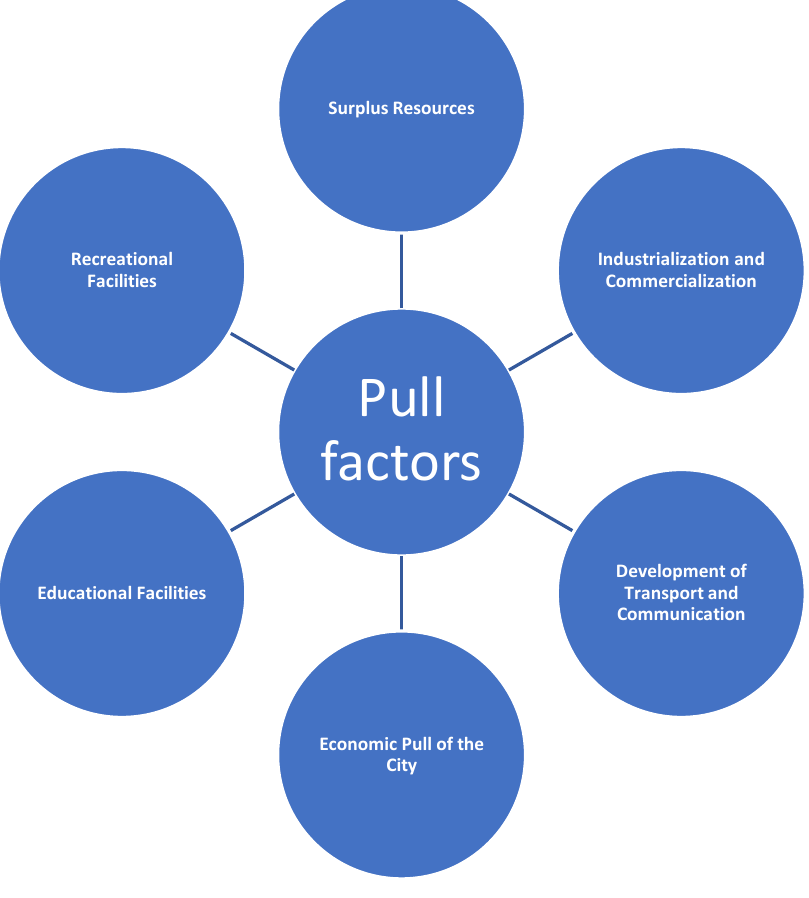
Figure 2. Pull factors of modern cities .